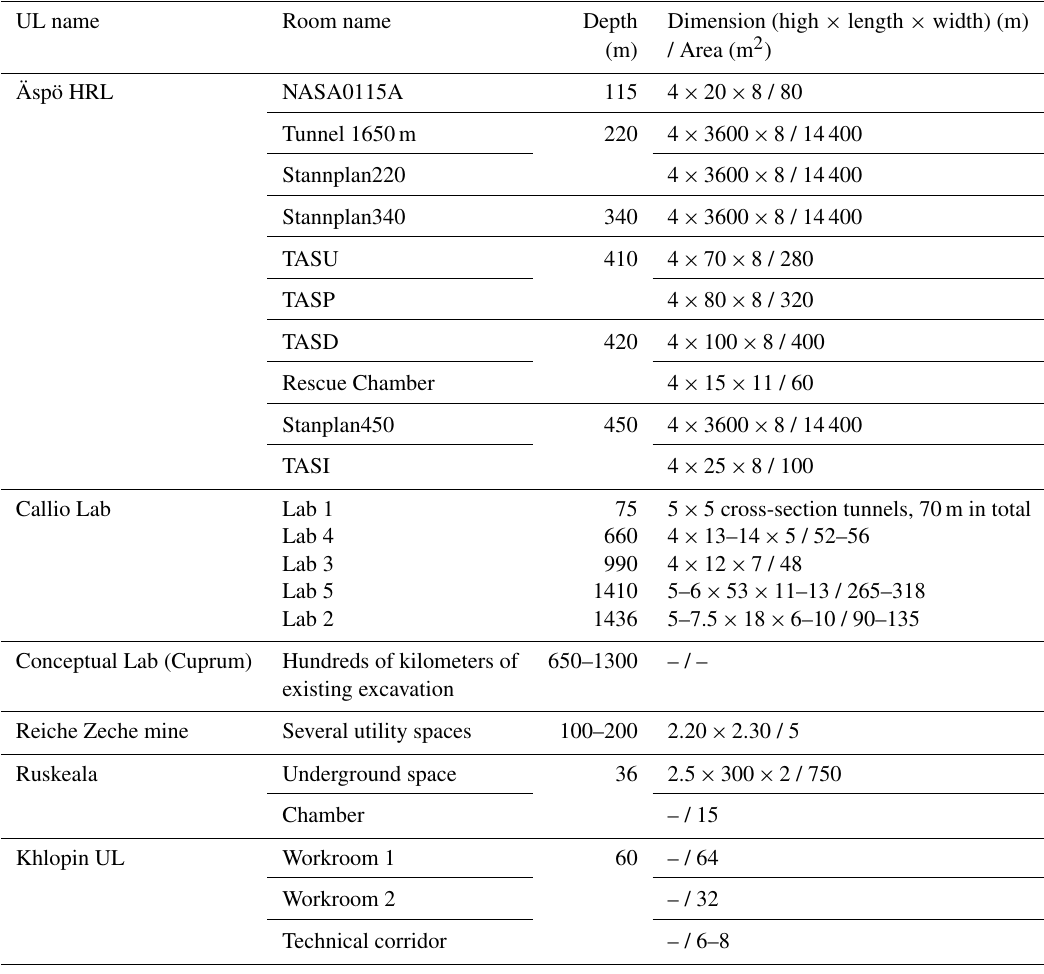
Table 1. Characteristics of BSUIN and EUL ULs underground rooms. The rooms are listed in order of depth.